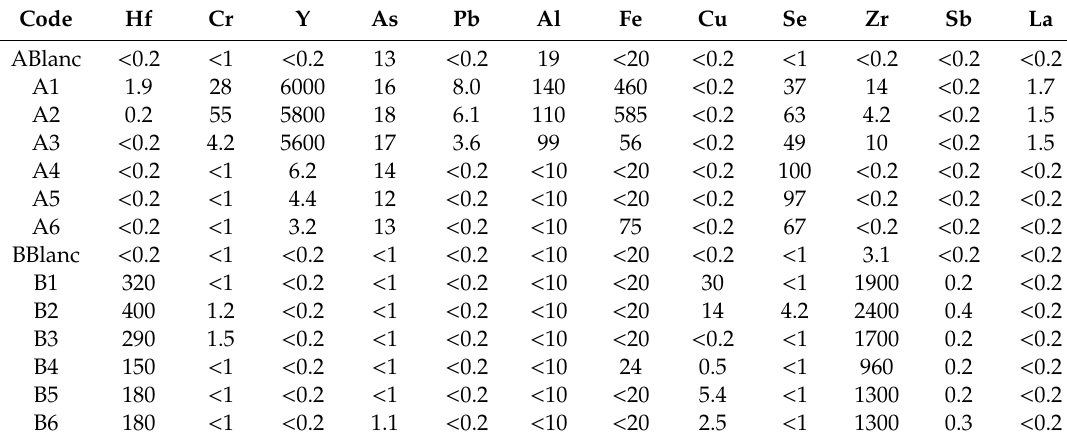
Table 3. The extraction results [ µ g / L].